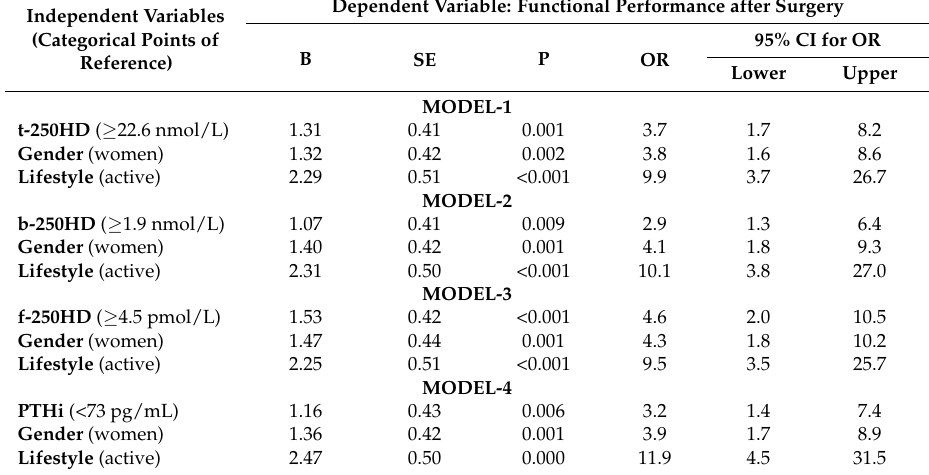
Table 3. Relationship between post-surgery functional performance and biomarkers related to gender and lifestyle. Independent Variables (Categorical Points of